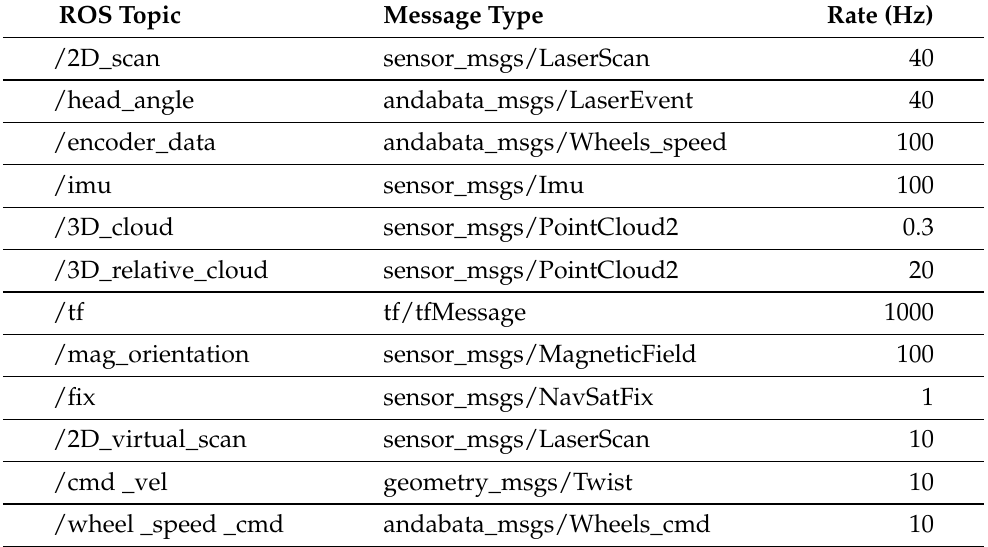
Figure 11. ROS computation graph. Driver nodes (Gazebo plugins for the simulated robot) are represented with blue ellipses instead of red squares. Table 3. Output rate of the ROS